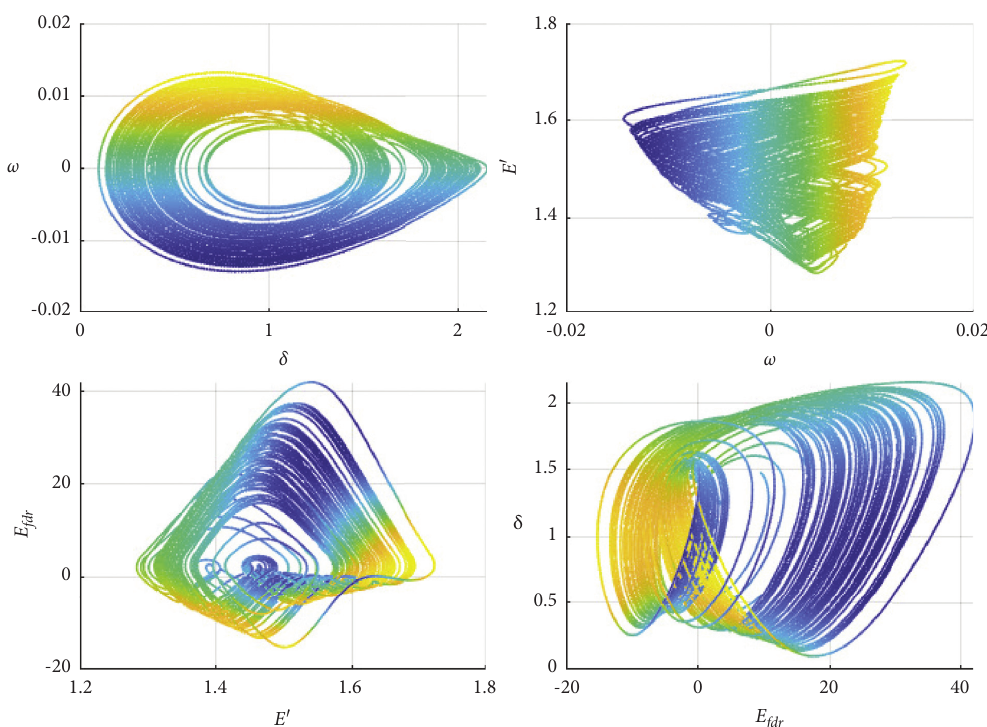
Figure 2: Phase portraits of chaotic integer-order four-dimensional power system (7) for different